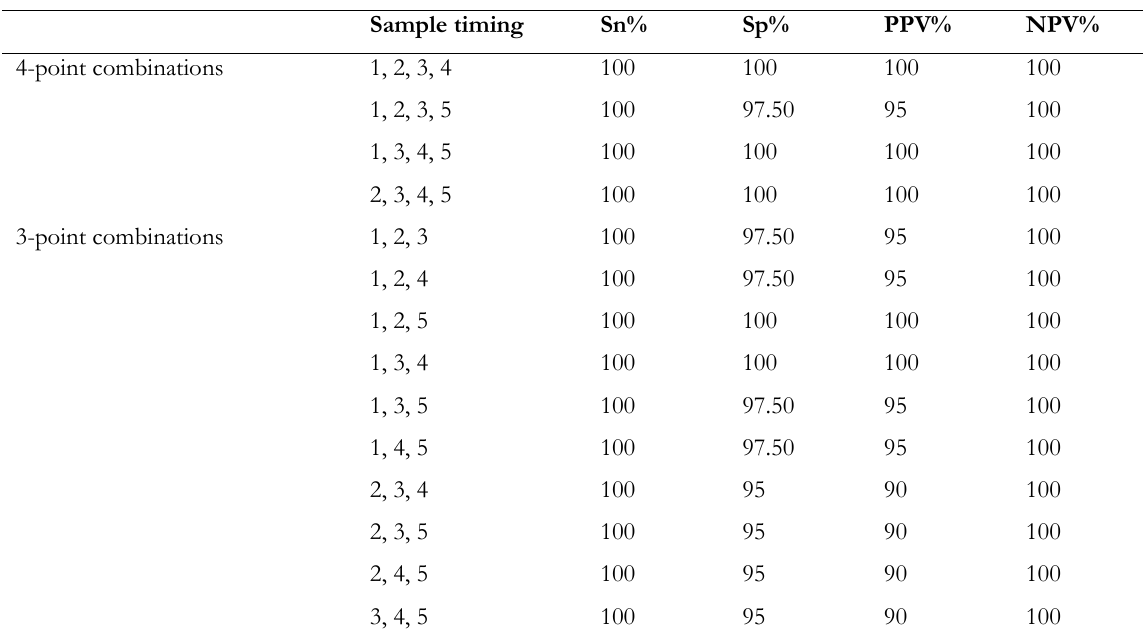
Table 1 Performance of different 3- and 4-point combinations in comparison to the gold standard 5-point